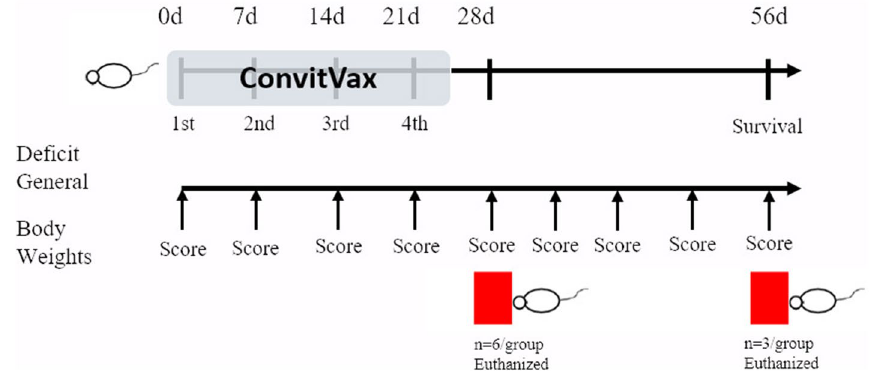
Figure 1. Timeline. The scheme represents the performed experimental